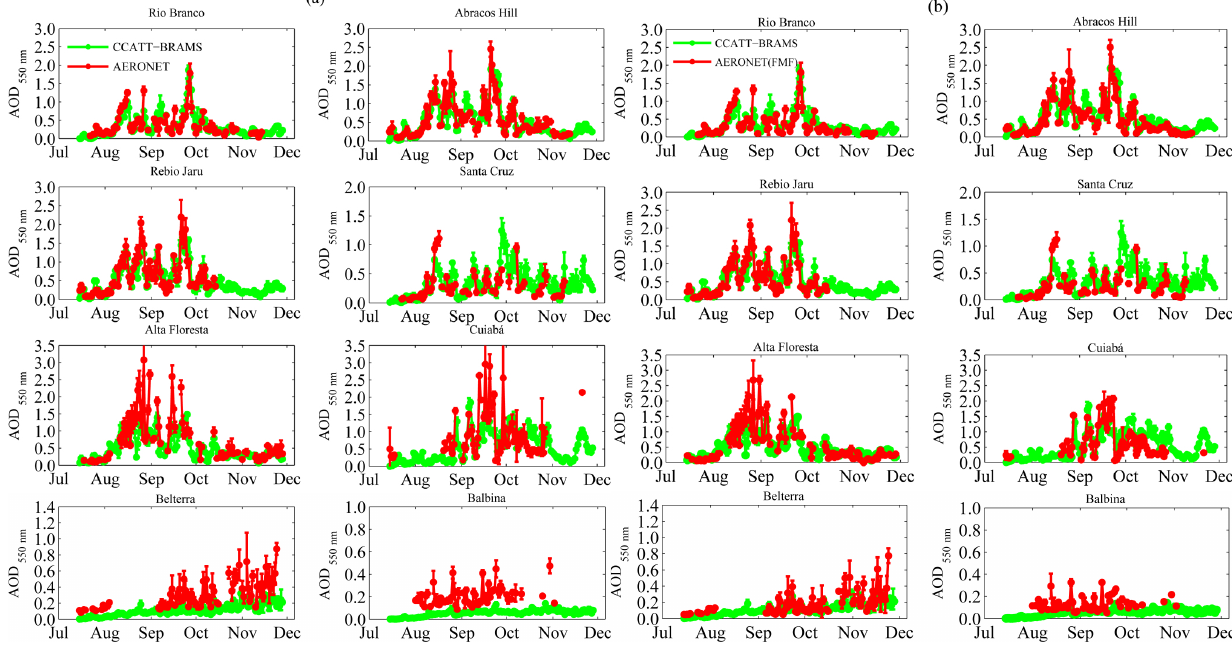
Fig. 3. Comparison of intra-seasonal variability of daily mean Aerosol Optical Depth (AOD) at 550nm modeled by CCATT-BRAMS with